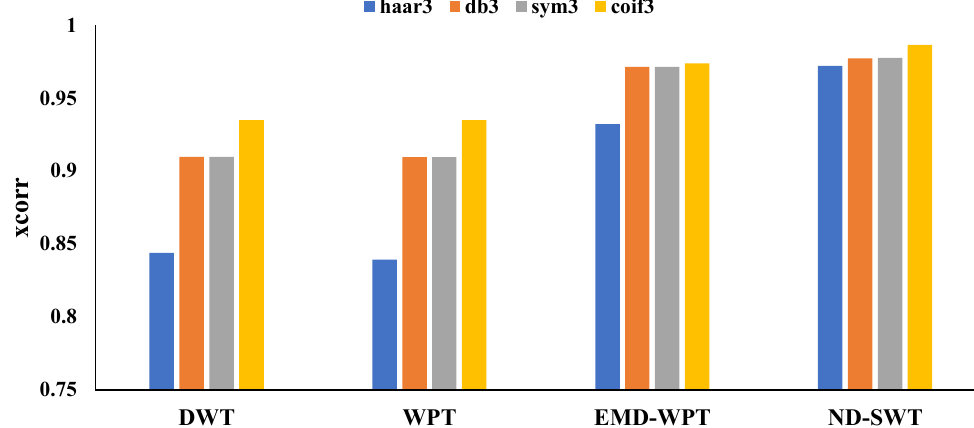
Figure 15. Comparison on cross-correlations of the simulation AE signal with respect to four methods using four different